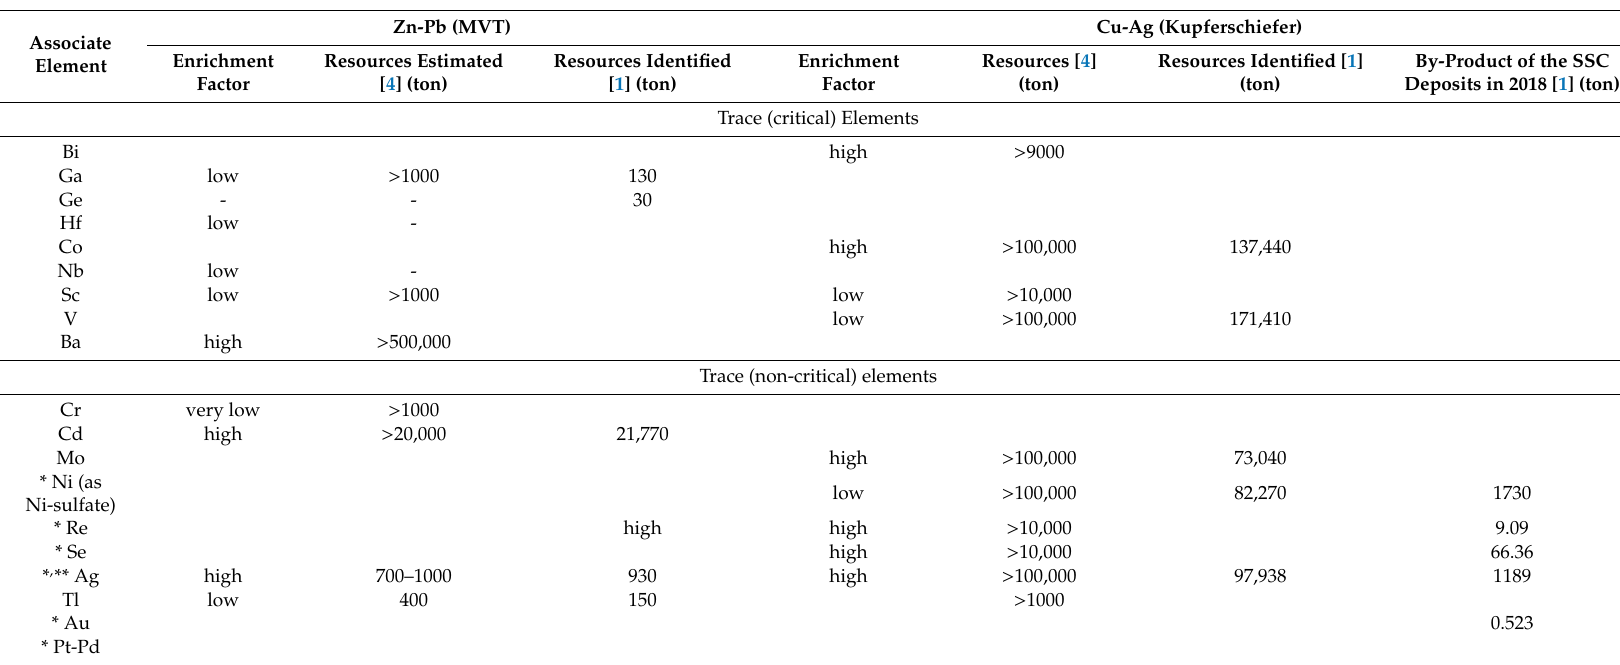
Table 12. Trace elements with the highest enrichment rates and estimated resources in documented Zn-Pb and Cu-Ag sediment hosted deposits in Poland considered as having potential economic profitability of extraction from the studied